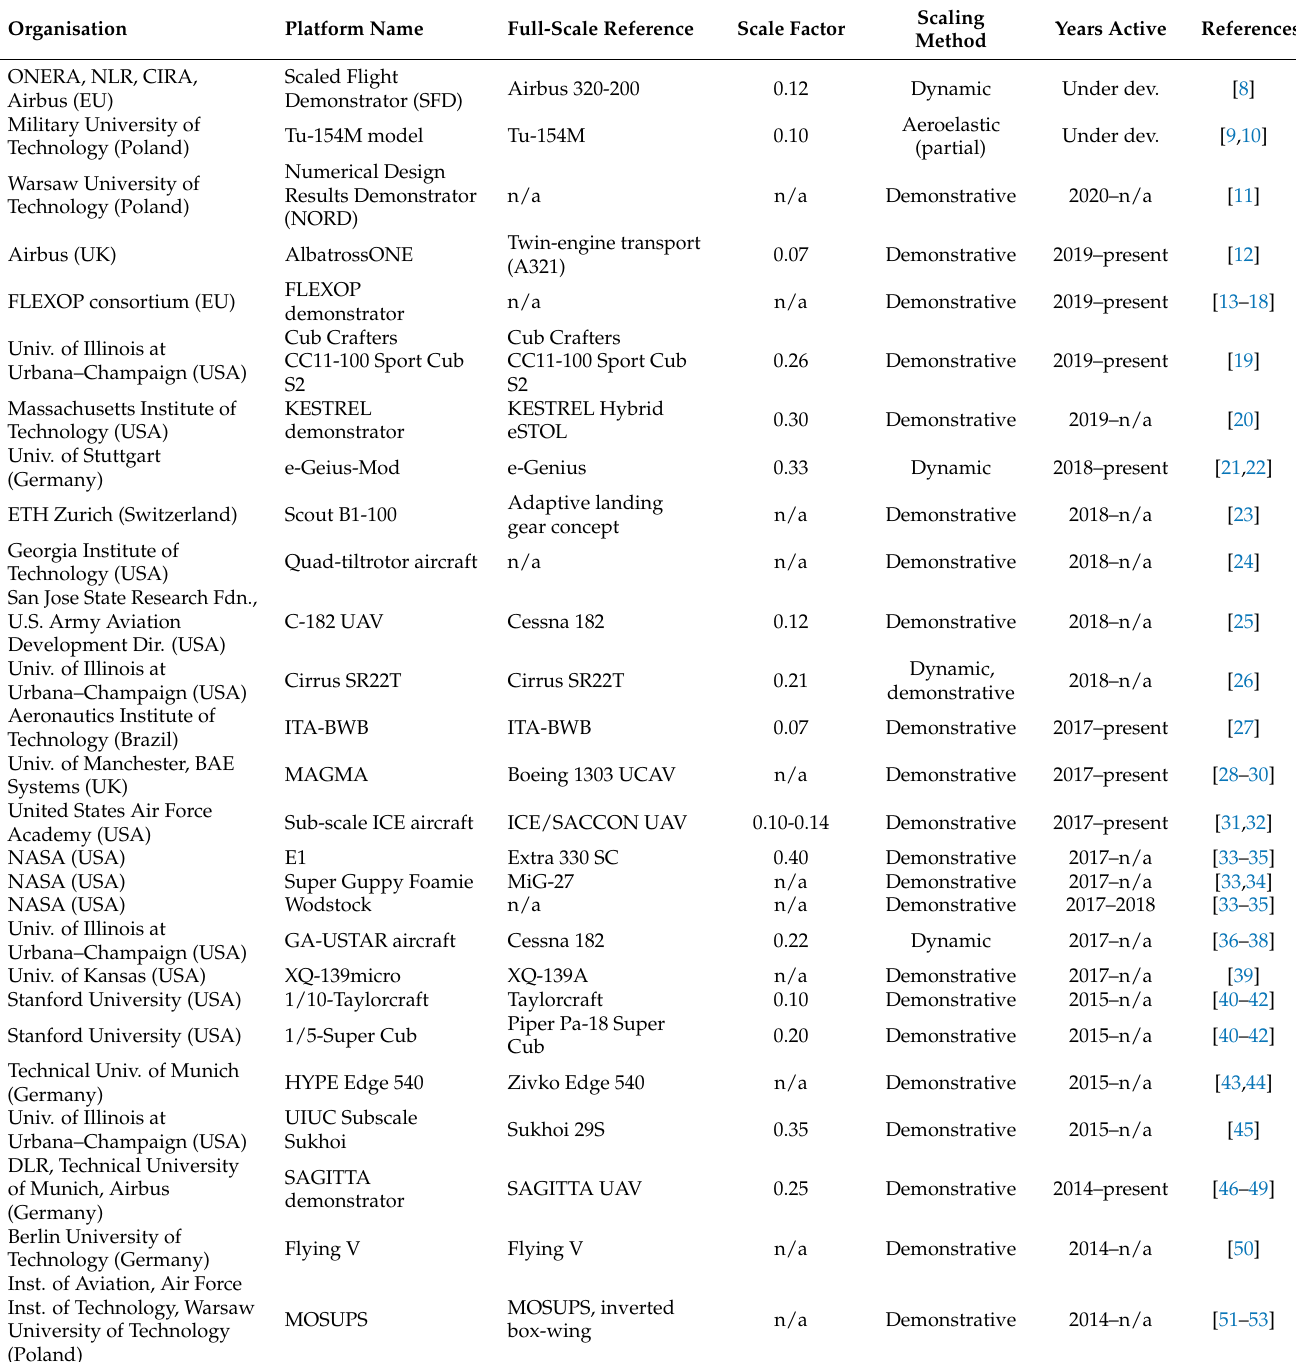
Table 3. Collection of SFT platforms that have been active or produced scientific publications in English during the last decade